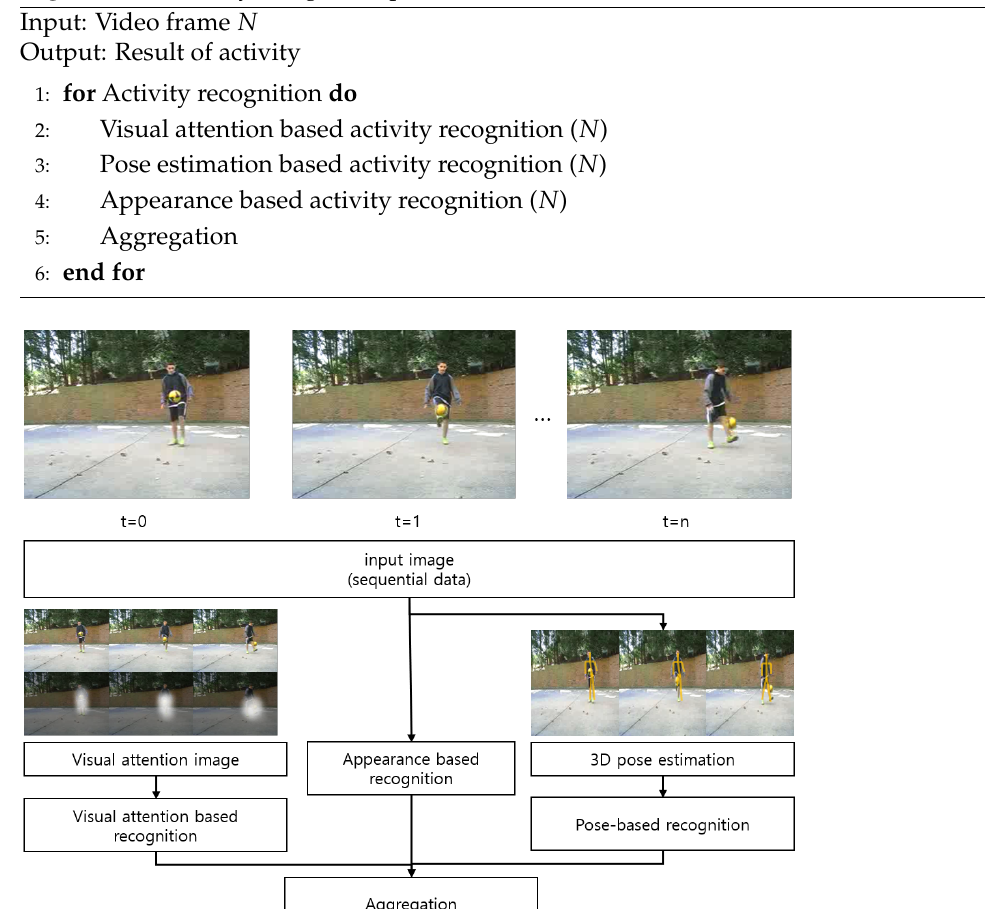
Algorithm 1 Activity recognition procedure.